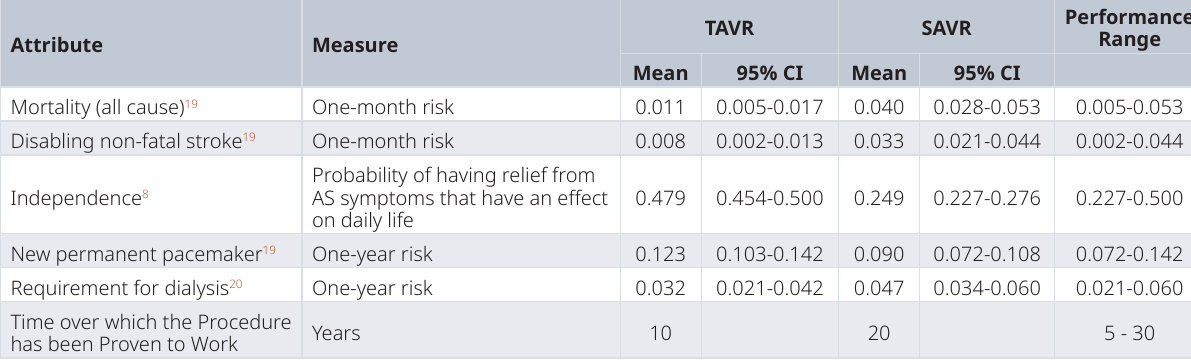
Table 2. Transcatheter aortic valve replacement (TAVR) and surgical aortic valve replacement (SAVR) performance against benefit-risk analysis attributes.